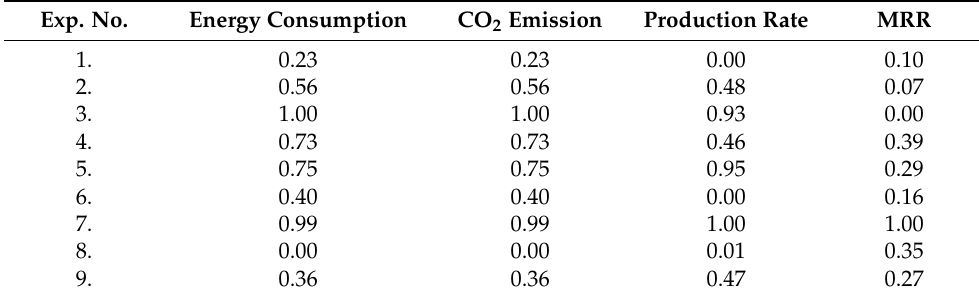
Table 5. Deviation sequence of the response.